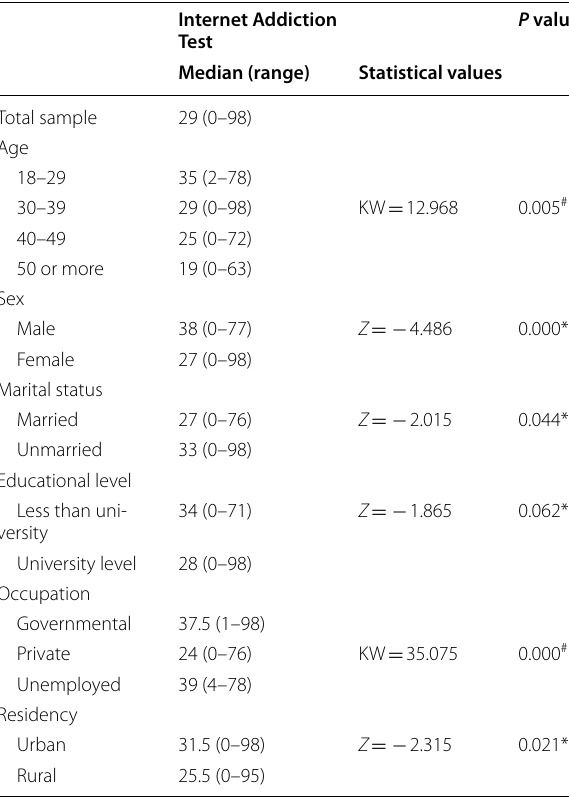
Table 3 Relation between Insomnia Severity Index (ISI) and sociodemographic data